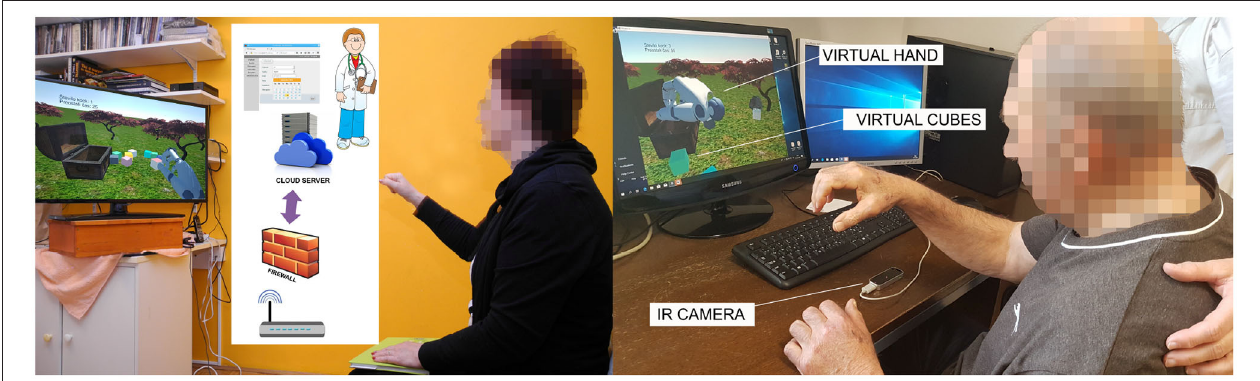
FIGURE 2 | Participants at exergaming in home (left) and hospital (right) environment. Both groups used the same 10Cubes game and LMC. The telerehabilitation system for the home group recorded the data locally and transferred afterwards to the server.